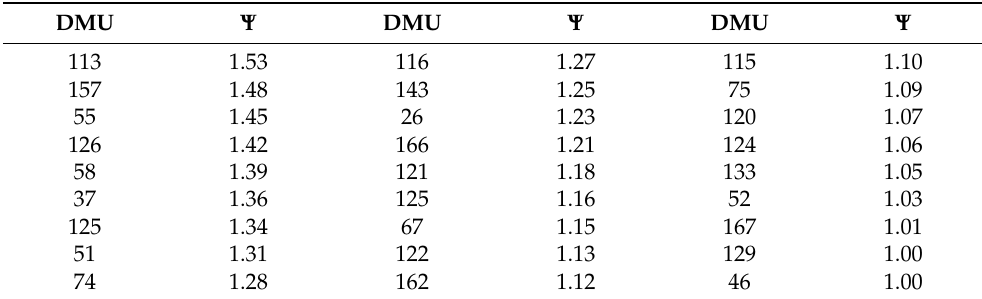
Table 3. Super-efficiency scores for the efficient DMUs (DMU numbers correspond to the ones in Table S2 in